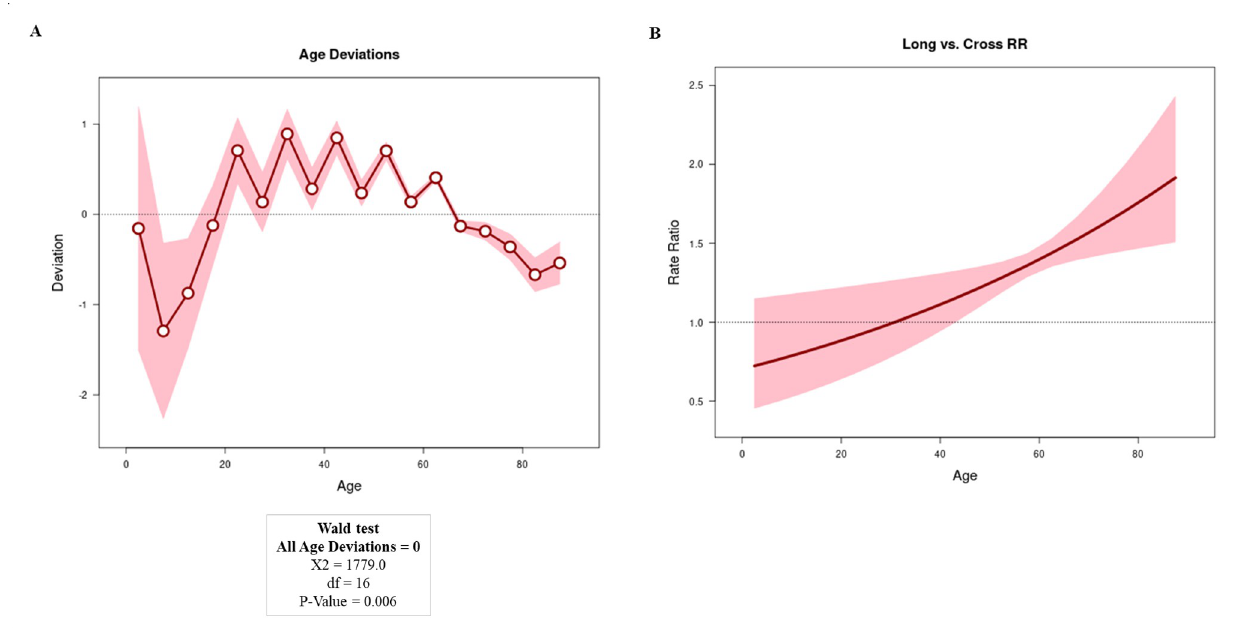
Fig 1. Age-period-cohort analysis using the Wald test (A), with the analysis of all age deviations (A) and the mortality rates (B) by age. In Fig 1A and 1B, the lines represent the oscillation of the Y-axis value in relation to the X-axis; the circle represents the moment on the X-axis; the shadows above the lines represent the 95%